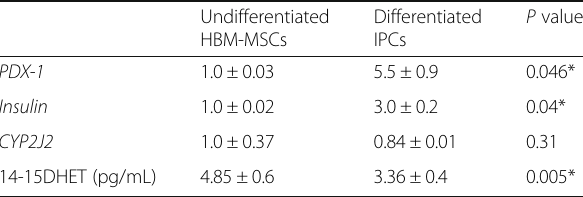
Table 2 Relative expression of PDX-1 , insulin , CYP2J2 genes, and 14, 15-DHET conc. level before and after differentiation of HBM- MSCs to IPCs